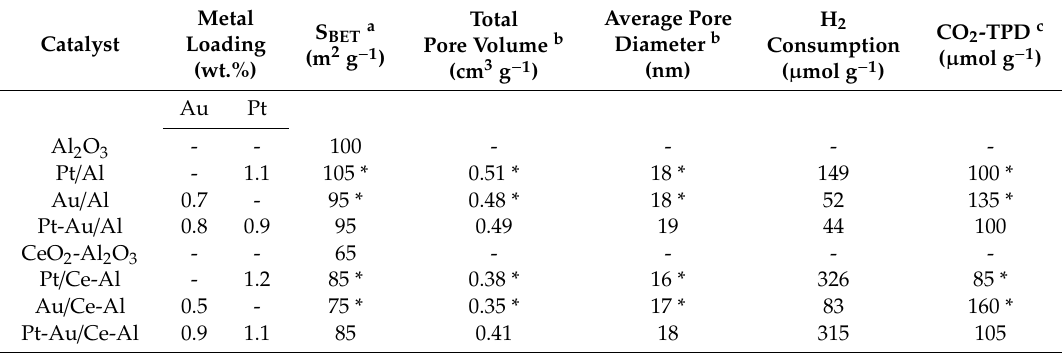
Table 2. Summary of the metal loading, surface area, total pore volume, average pore diameter, reducibility, and basicity of the tested catalysts. The results were discussed in detail in References [27,28]. The results marked with * are the new results originating from this study.